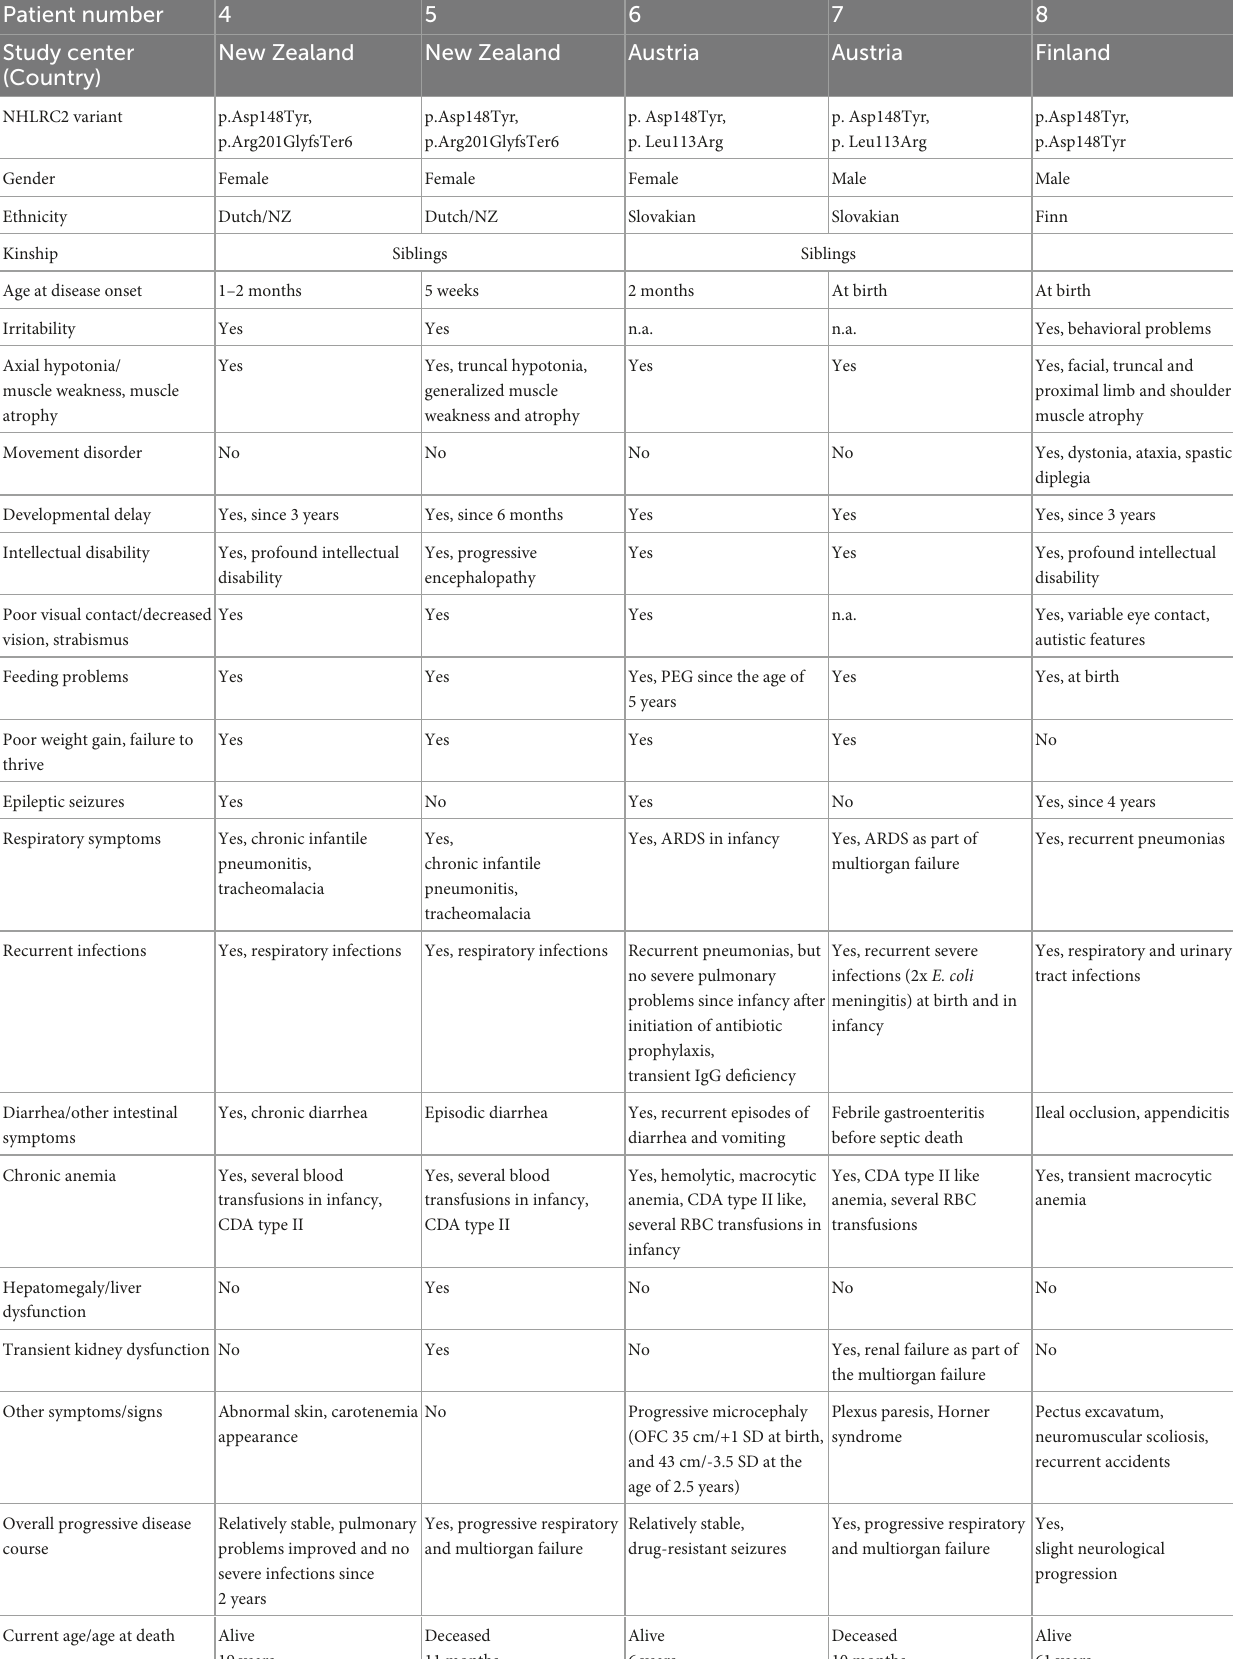
TABLE 1 Genetic findings and clinical features of the five novel FINCA patients. Patient